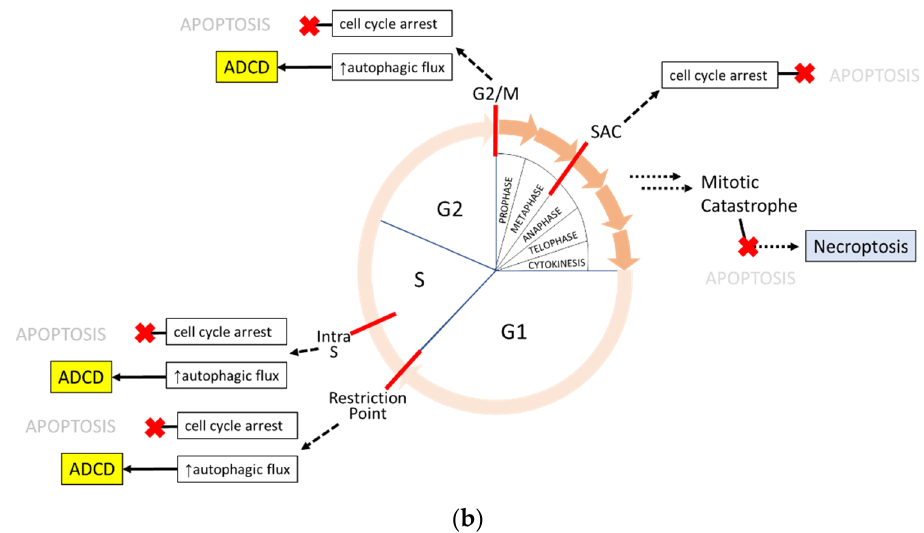
Figure 3. Cell cycle-mediated cell death occurs through non-immunogenic death pathways. ( a ) Cyclin-dependent kinase (CdK) inhibitors act in response to many stressors to arrest the cell cycle and increase autophagic flux. When damage cannot be resolved, autophagy is terminated and the cell commits to apoptosis. Cell death from mitotic catastrophe also proceeds through apoptosis. ( b ) When the apoptosis pathway is compromised or inhibited, as is commonly seen in cancer, cell death may occur through other pathways. Prolonged cell cycle arrest can lead to sustained autophagy and presumably lead to autophagy-dependent cell death (ADCD). During a mitotic catastrophe, spontaneous ripoptosome formation could enable necroptosis without TNF signaling. Blue death programs are immunogenic; yellow are non-immunogenic.